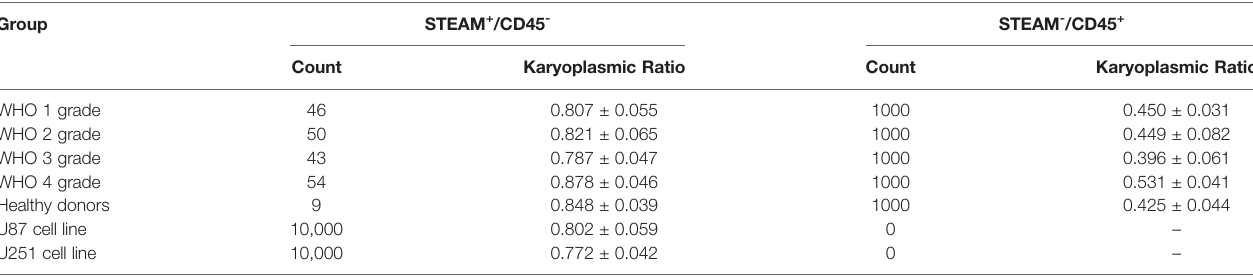
TABLE 2 | Quantization of karyoplasmic ratio in clinical samples and cell lines.